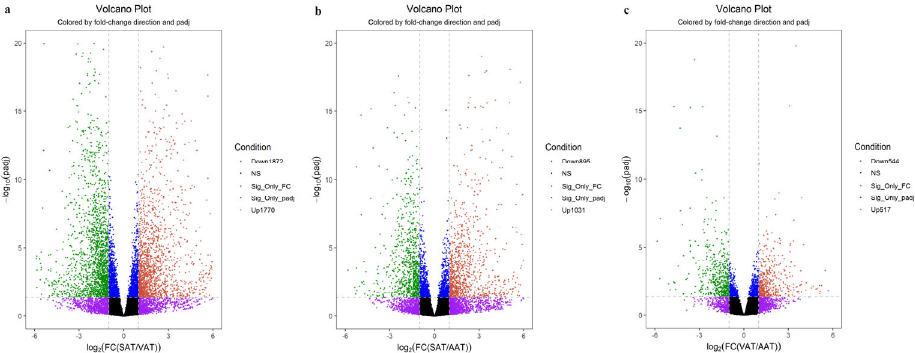
Figure 2. Volcano plots of differentially expressed genes in SAT − VAT ( a ), SAT − AAT ( b ), and VAT − AAT ( c ) comparative groups. The red and green dots represent the up-regulated and down- regulated genes,